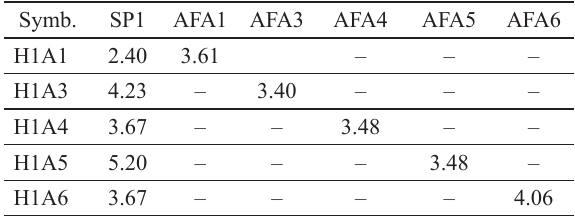
Table 2. The properties of anti-foaming admixtures Symbol